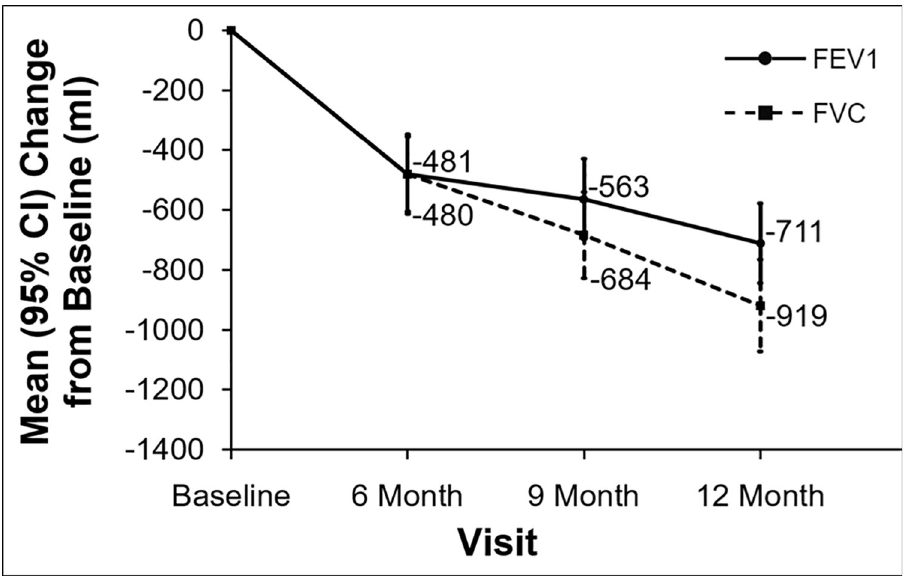
Fig 3. Pulmonary function during observation–imputation 50% baseline for death and worst of last or next observation for other reasons of missing values (method of imputation used in EPOS trial). FEV 1 –forced expiratory volume in 1 second, FVC- forced vital capacity, ml–milliliters, CI–confidence interval.